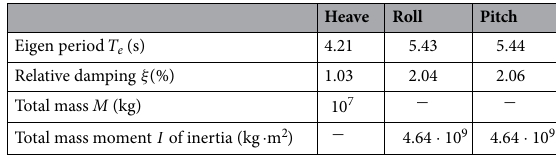
Table 1. TLP particulars.